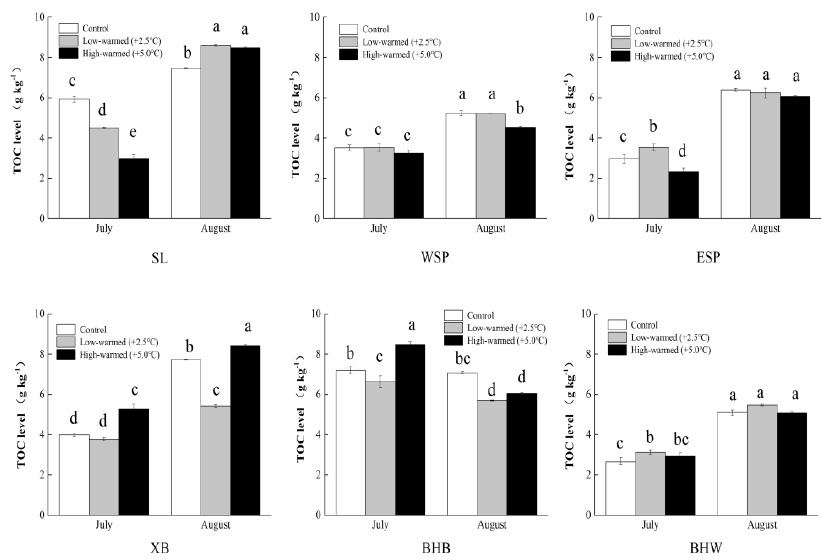
Figure 3. Contents of total organic carbon (TOC) in sediments collected from wetland pillars in the temperature simulation experiment (control: ambient temperature; low-warmed: ambient temperature +2.5 °C; high-warmed: ambient temperature +5.0 °C). The abbreviation of wetland sampling sites is identified on the x -axis, and the TOC content in the sediments is identified on the y -axis. Error bars represent the standard error of the mean of three parallel samples. Values within the same sampling site follow by the same small letters (a, b, c, d, e) are not significantly different at p = 0.05.